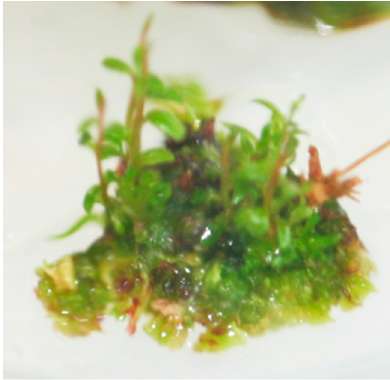
Figure 3. In vitro shoot regeneration in lingonberry.